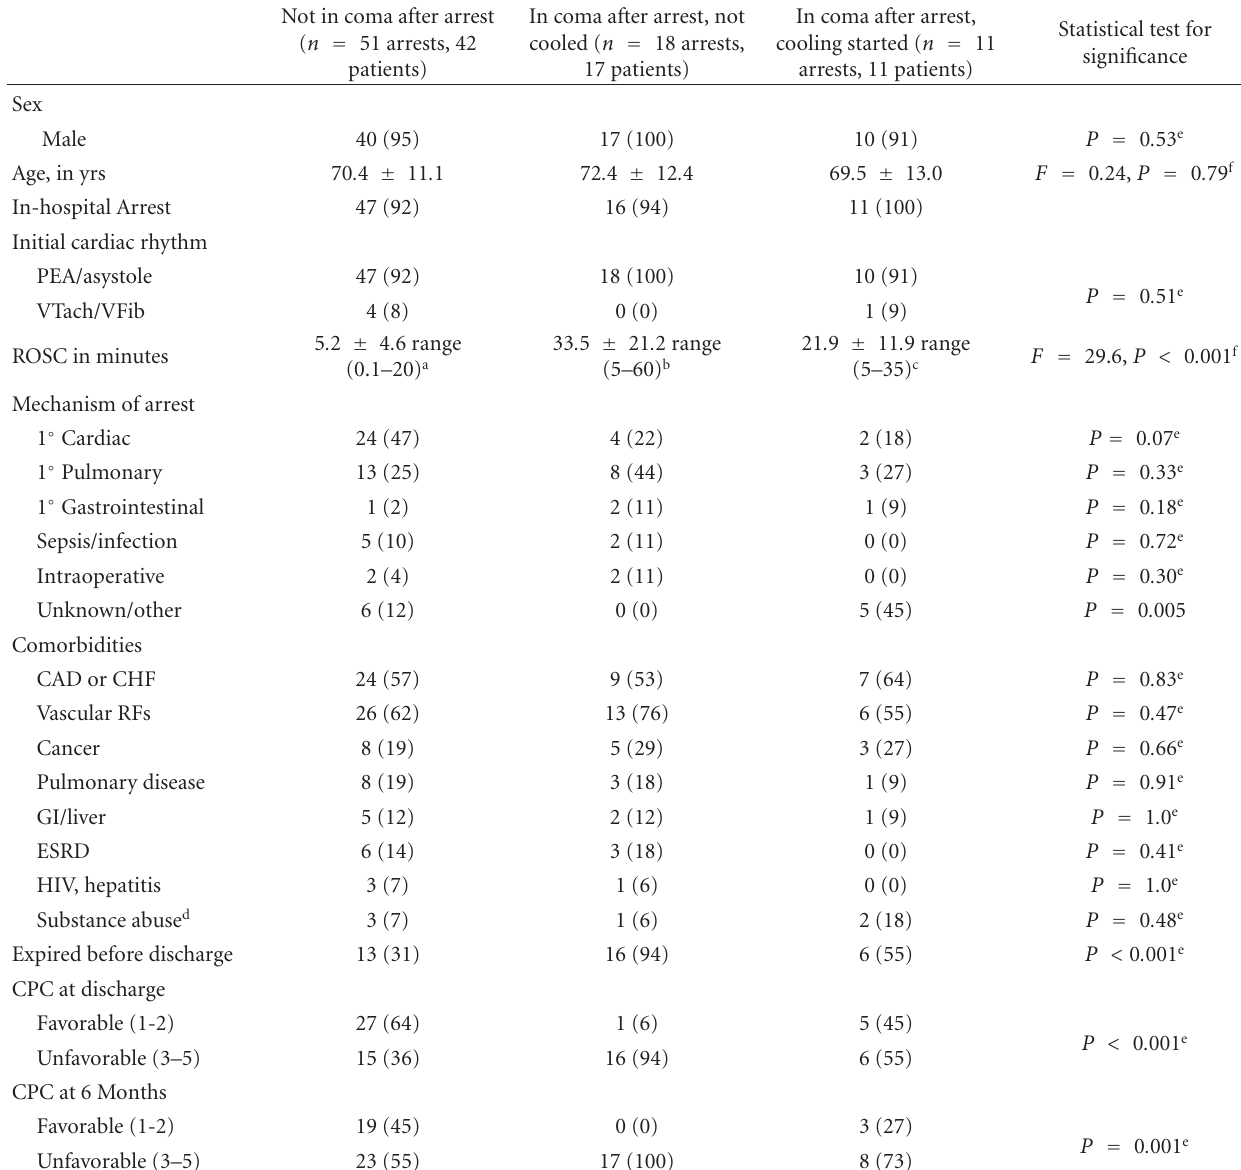
Table 1: Characteristics of cardiac arrests in which patient